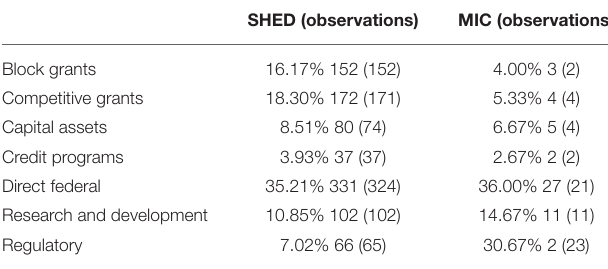
TABLE 2 | Types of programs administered by different organizations. SHED (observations) MIC